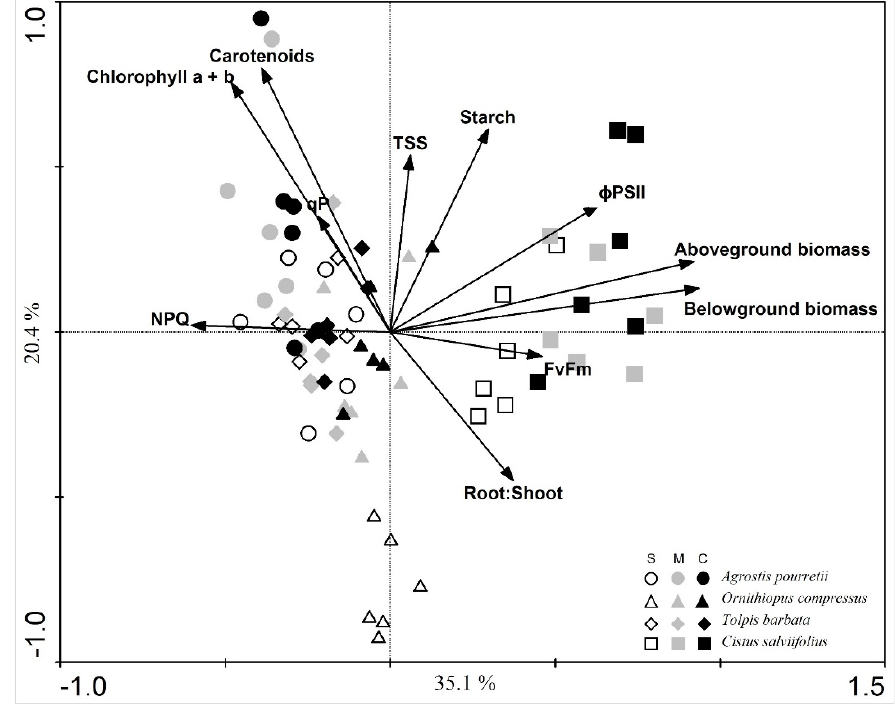
Figure 7. Scatterplots of principal components analysis of physiologic and morphologic variables of plants of each functional group under severe water deficit, moderate water deficit and control.